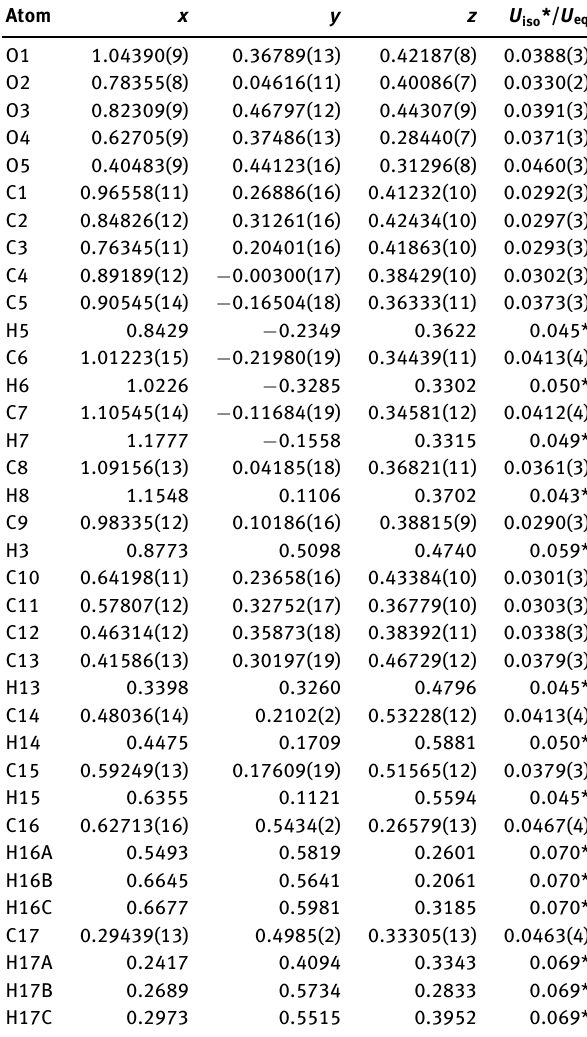
Table 2: Fractional atomic coordinates and isotropic or equivalent isotropic displacement parameters (Å 2